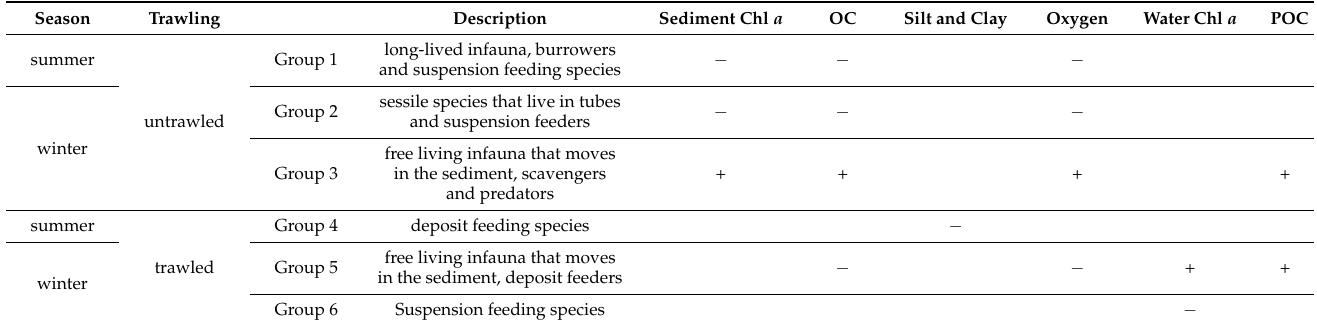
Figure 4. Oxygen flux rates (micromole per square metre per hour) from the trawled and untrawled sampling sites with mean and standard deviation in summer and winter. Grey bars indicate the eastern sites and white bars the western sites. Table 3. Summary of the major functional groups related (positively: + and negatively: − ) to specific biogeochemical processes in different trawling intensities and seasons. OC: organic carbon, POC: particulate organic